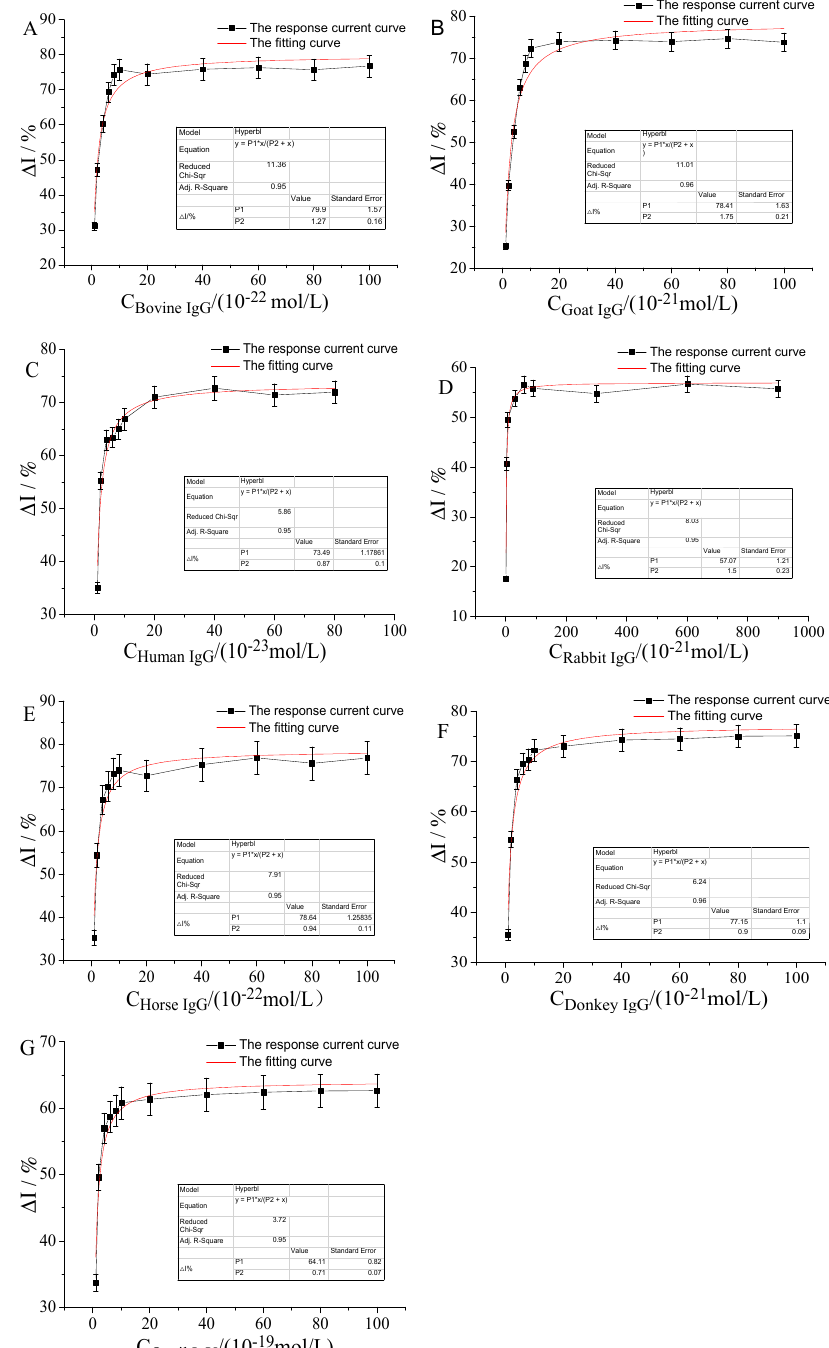
Figure 8. The current change curve and corresponding fitting curve of seven IgGs detected in a certain concentration range. ( A ) Bovine IgG 10 − 22 to 10 − 20 mol/L, ( B ) sheep IgG 10 − 21 to 10 − 19 mol/L, ( C ) human IgG 10 − 23 to 10 − 21 mol/L, ( D ) rabbit IgG 10 − 21 to 10 − 18 mol/L, ( E ) horse IgG 10 − 22 to 10 − 20 mol/L, ( F ) donkey IgG 10 − 21 to 10 − 19 mol/L, and ( G ) quail IgY 10 − 19 to 10 − 17 mol/L.